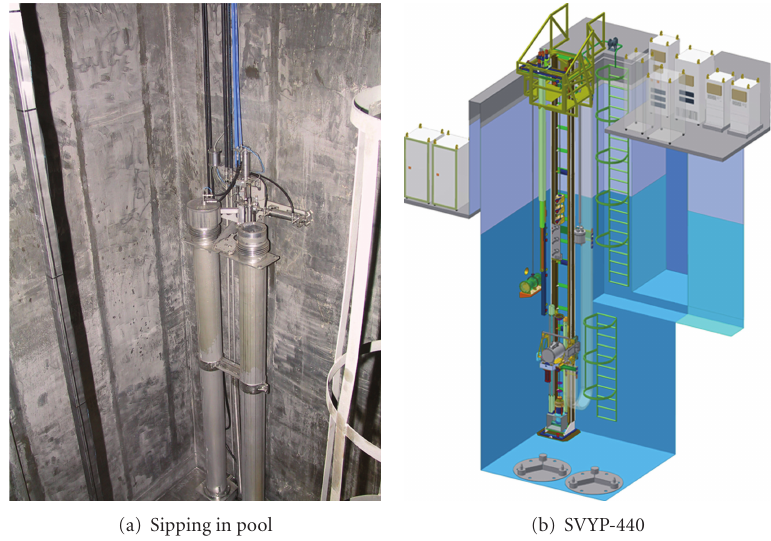
Figure 1: Equipment for VVER-440 spent fuel assemblies control in Slovakia.